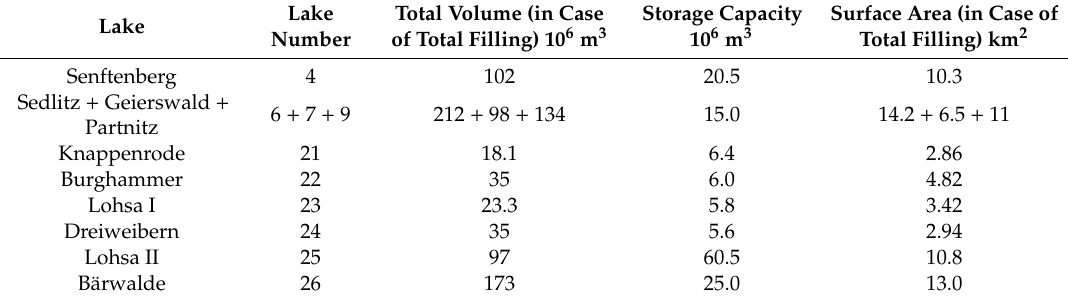
Table 4. Storage capacity and total volume of the pit lakes used for flood protection and water storage and shown in Figure 7 (data provided by Landestalsperrenverwaltung des Freistaates Sachsen, Lausitzer und Mitteldeutsche Bergbau-Verwaltungsgesellschaft, Landesamt für Umwelt Brandenburg). Lake Total Volume (in Case Storage Capacity Surface Area (in Case of Lake Number of Total Filling) 10 6 m 3 10 6 m 3 Total Filling) km